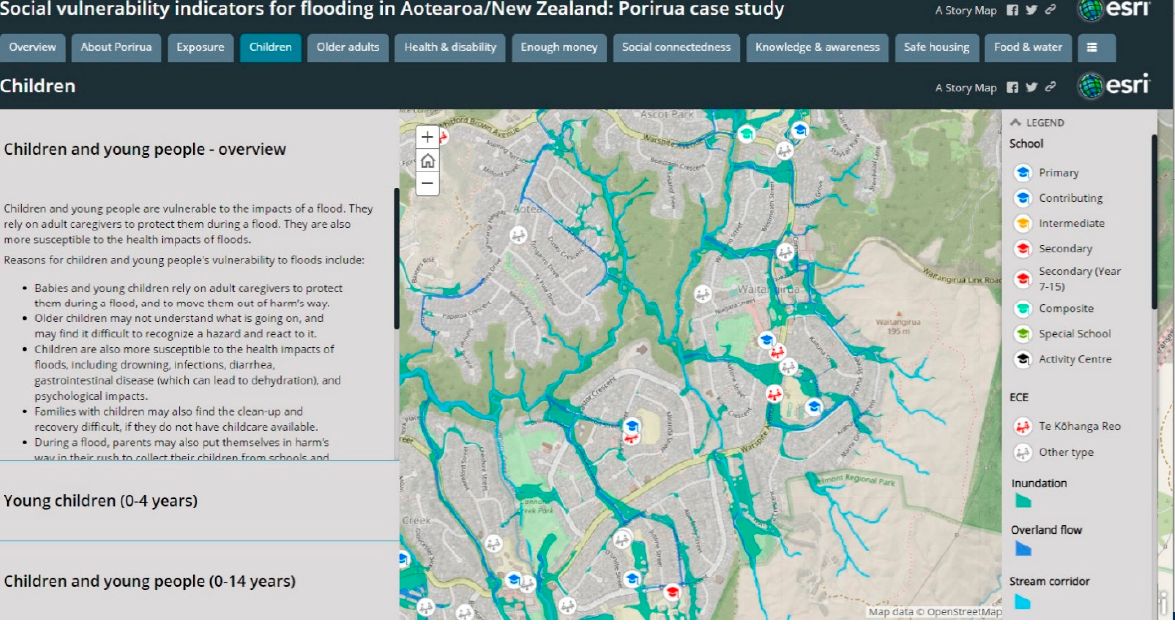
Figure 6. Screenshot of the online interactive map (Story Map) of flood hazard zones and school locations for Waitangirua, Porirua. Note: Flood hazard zones show 1-in-100 year flood extents, accounting for 100 year climate change impacts. Source: Wellington Water, Porirua City Council.